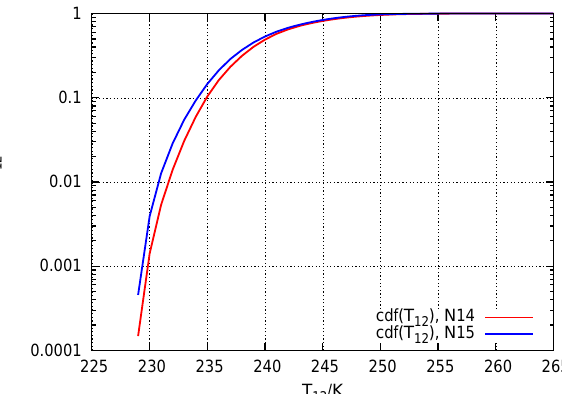
Figure 4. Cumulative distribution functions (cdf) of channel 12 brightness temperatures, measured with HIRS 2 on N14 (red) and with HIRS 3 on N15 (blue). Note the quite large discrepancy (in relative terms) between both cdf’s at low values of T 12